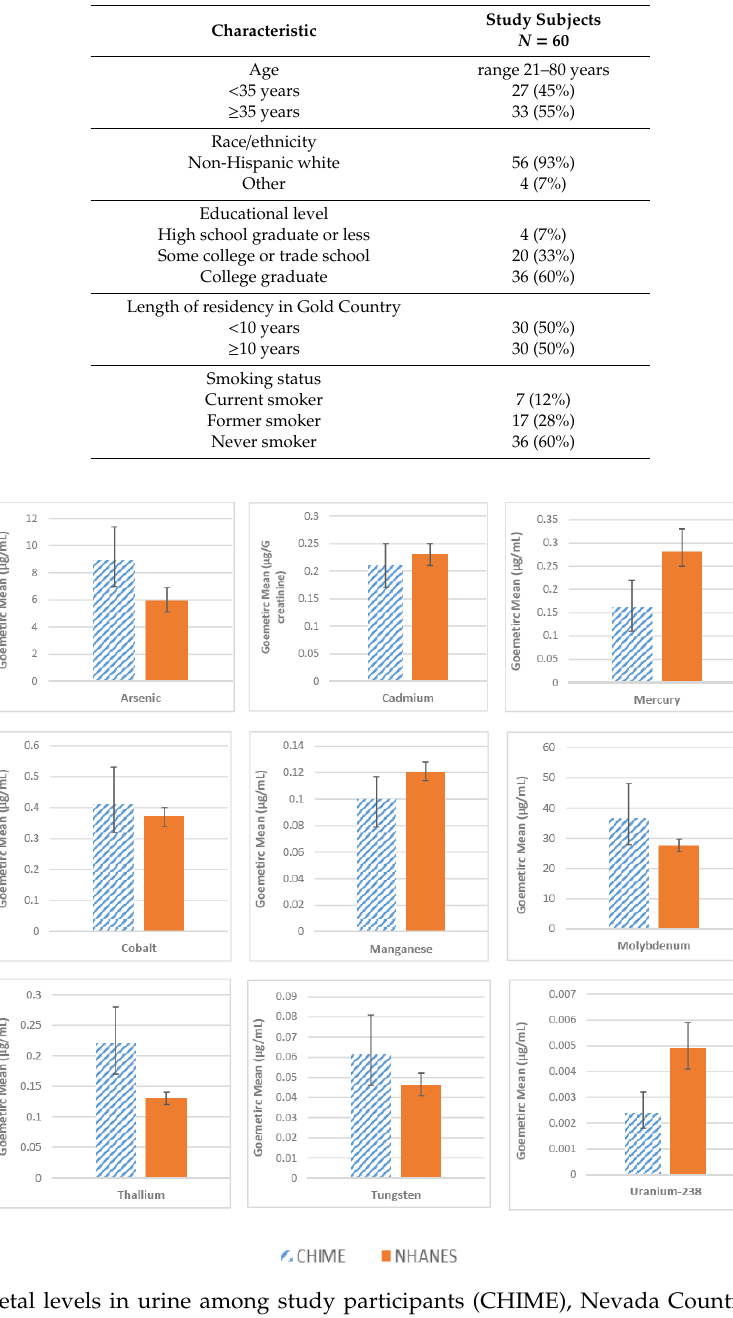
Table 2. Demographic characteristics of the 60 female study participants, 2014, Nevada County, California.